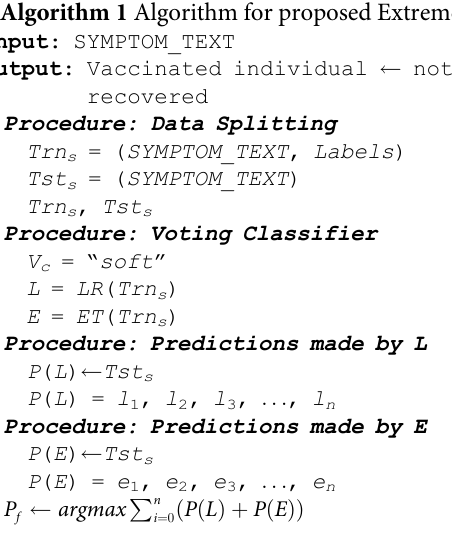
Algorithm 1 Algorithm for proposed Extreme Regression-Voting Classifier